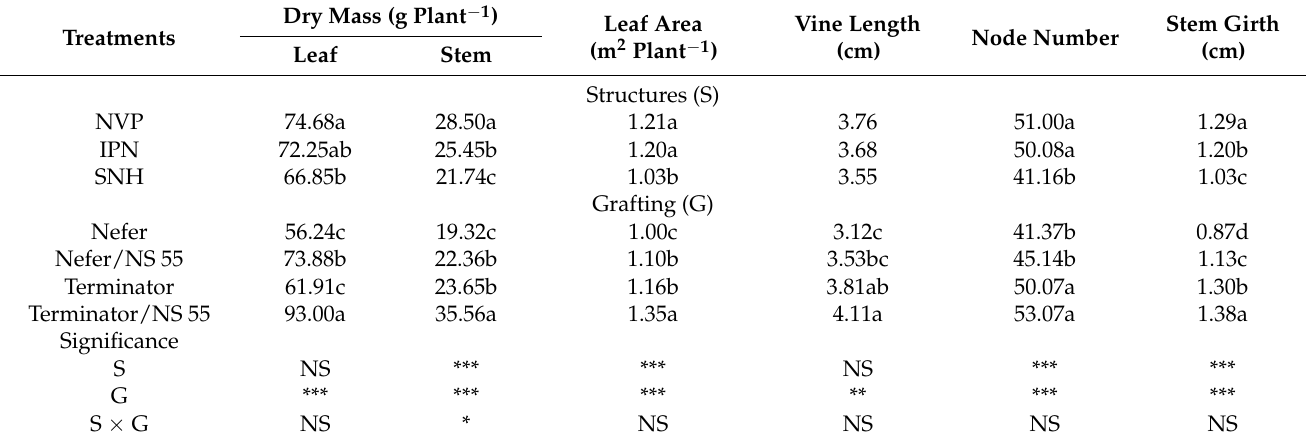
Table 2. Effect of structures and graft combinations on growth